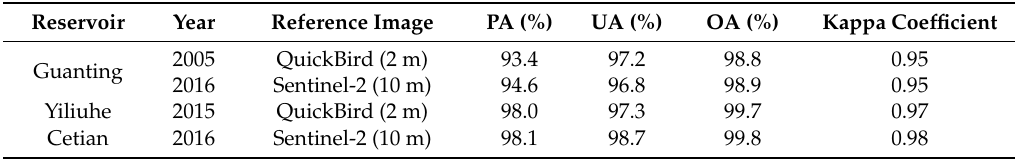
Table 2. Accuracies of the extracted reservoir water